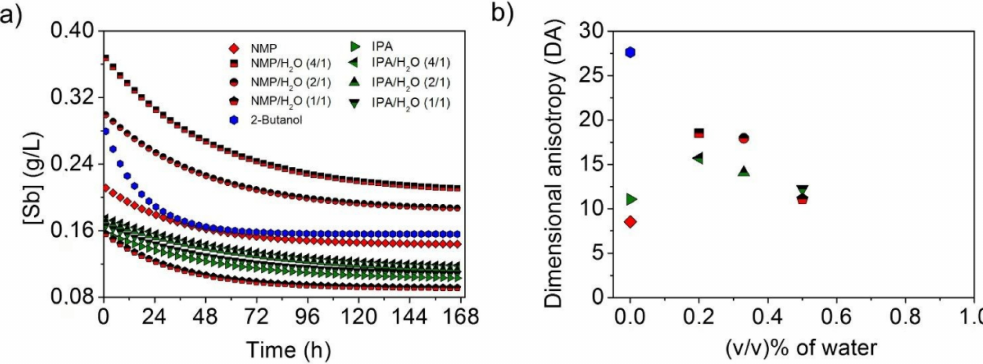
Figure 5. ( a ) The concentration of antimonene in the suspension after centrifugation [Sb] (g ∙ L − 1 ), plotted with the precipitation time of the sample prepared with the solvent described in the legend; ( b ) the relationship between the DA ratio of antimonene nanolayer and the volume fraction (%) of water in the solvent mixture. Reprinted with permission from Ref. [44]. Copyright 2019, Royal Society of Chemistry.